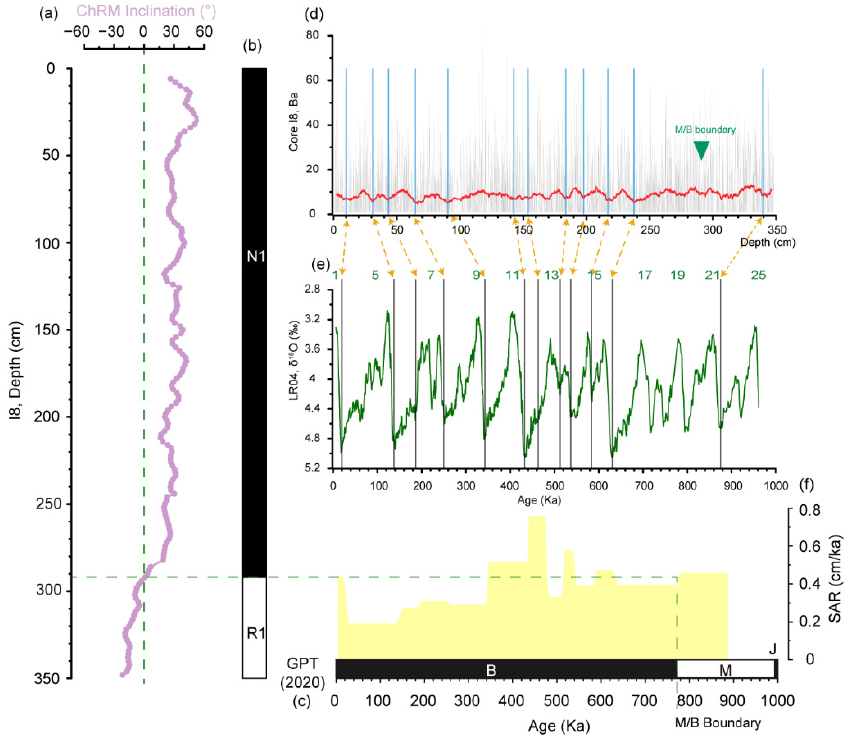
Figure 2. Chronostratigraphic framework of core I8 [18]. ( a ), ChRM inclination of core I8; ( b ), polarity of core I8; ( c ), geological polarity timescale (GPT2020); ( d , e ) tuning Ba intensities to LR04 δ 18 O record, M/B boundary is the boundary of the magnetic Matuyama and Brunes chronons (~773 ka), green numbers 1–25 represent the marine isotope stages; ( f ), sediment accumulation rate (SAR).